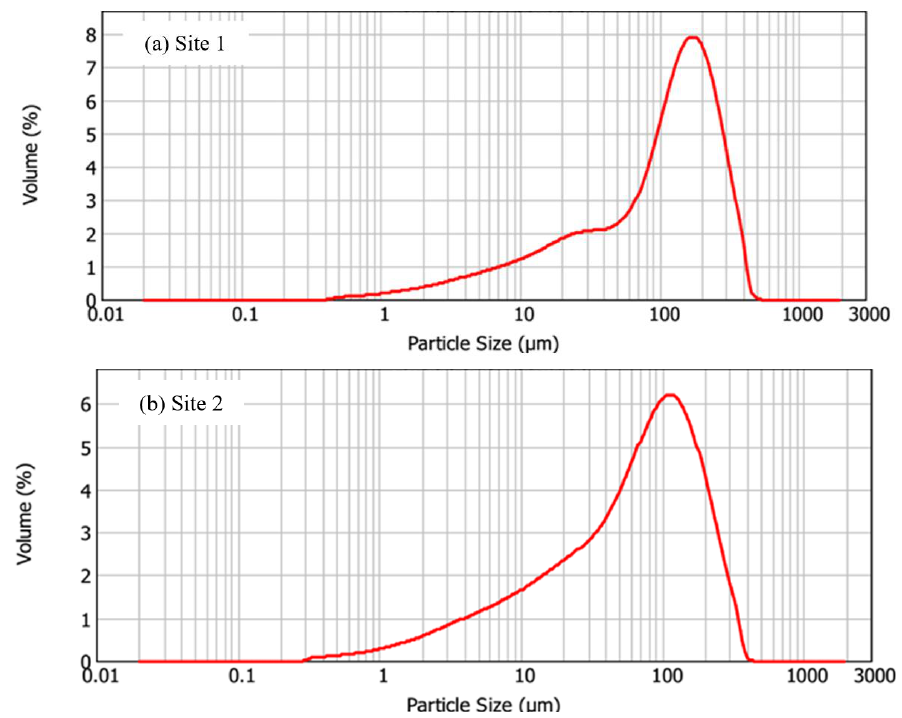
Figure 1. Particle size distributions for the ( a ) Site 1 sample [d(0.1): 10.37 µm, d(0.5): 116.47 µm, d(0.9): 272.50 µm] and ( b ) Site 2 sample [d(0.1): 6.34 µm, d(0.5): 67.77 µm, d(0.9): 199.37 µm]. 272.50 µ m] and ( b ) Site 2 sample [d(0.1): 6.34 µ m, d(0.5): 67.77 µ m, d(0.9): 199.37 µ